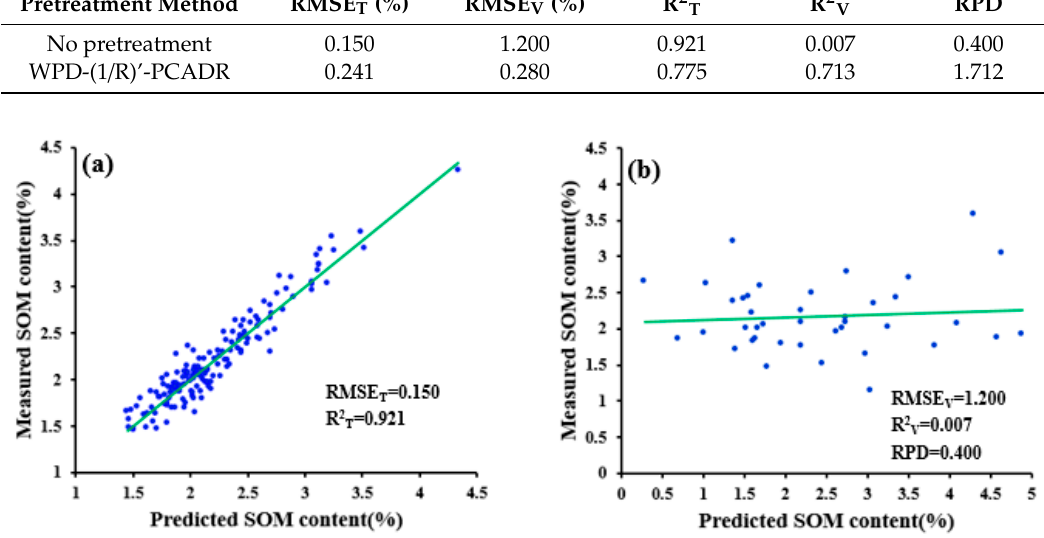
Figure 5. SOM content estimation results based on PLSR model for ( a ) training and ( b ) validation sets of untreated data.